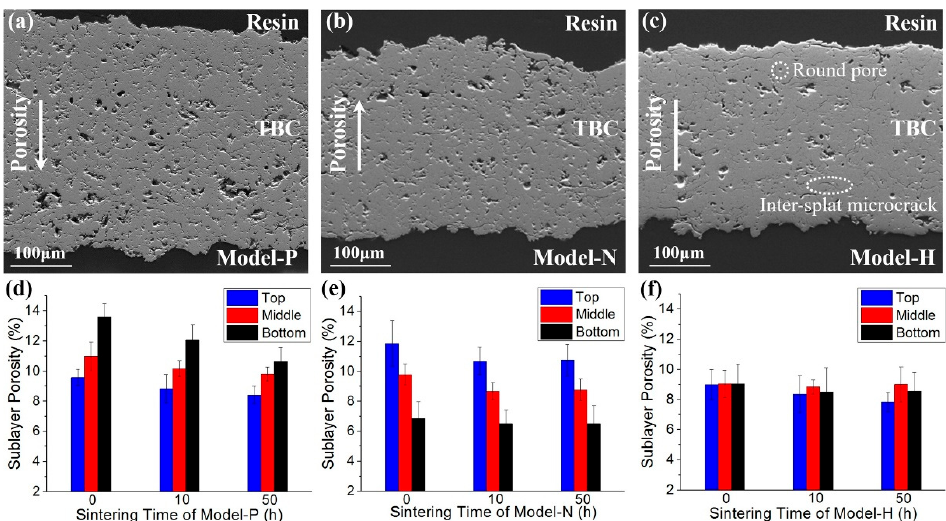
Figure 19. SEM cross-sections of as-sprayed, free-standing TBCs with different porosity gradients: ( a ) positive gradient (Model-P) with increasing porosity from top to bottom ( b ) negative gradient (Model-N) with decreasing porosity ( c ) homogeneous porosity (Model-H) with uniform porosity distribution; porosity distributions of top, middle and bottom sublayers at different sintering time in ( d ) Model-P ( e ) Model-N ( f ) Model-H [140] .